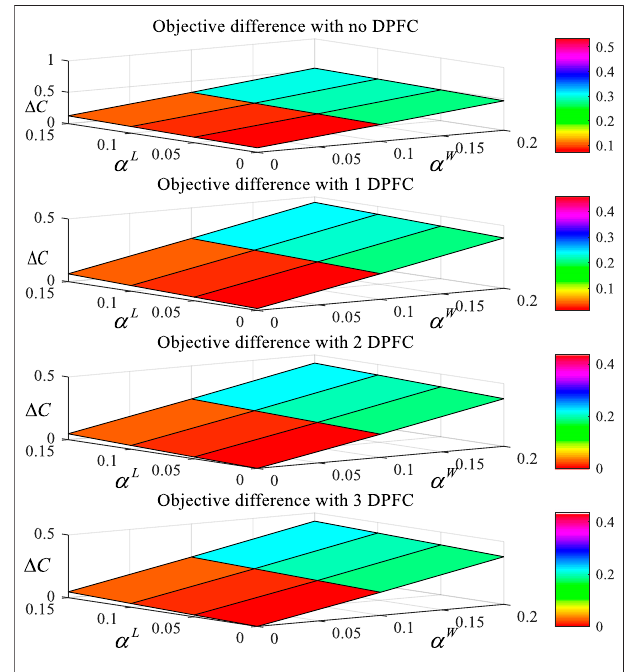
FIGURE 9 | Objective difference with different numbers of the